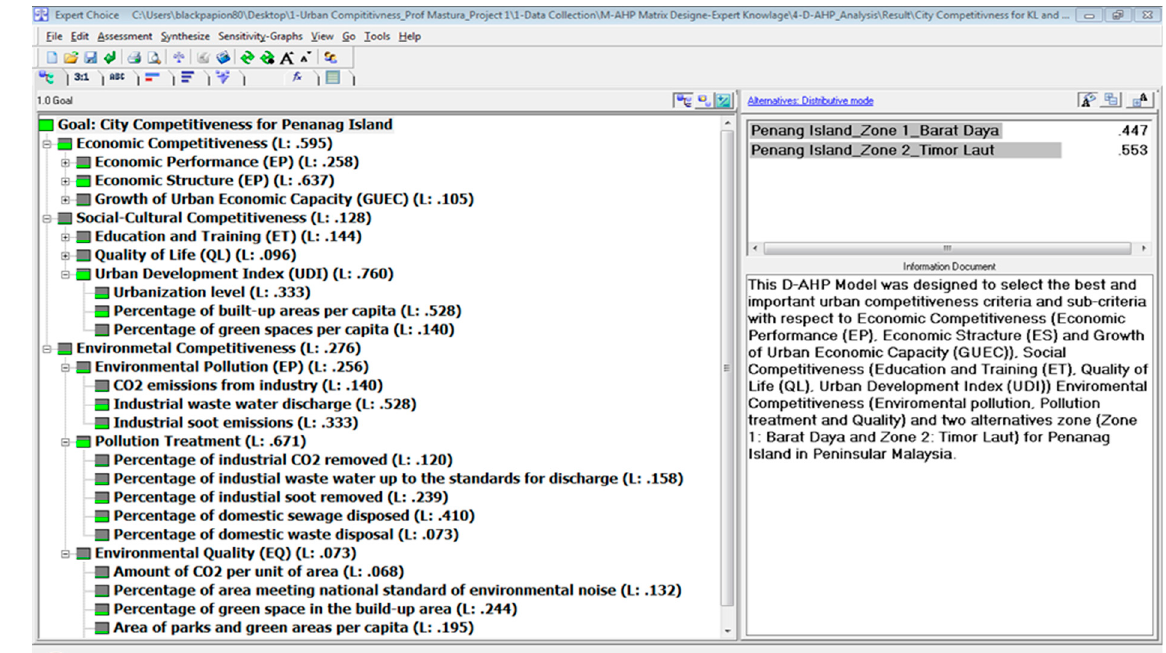
Figure 3. Hierarchy design and levels in the expert choice software environment for the DAHP model.